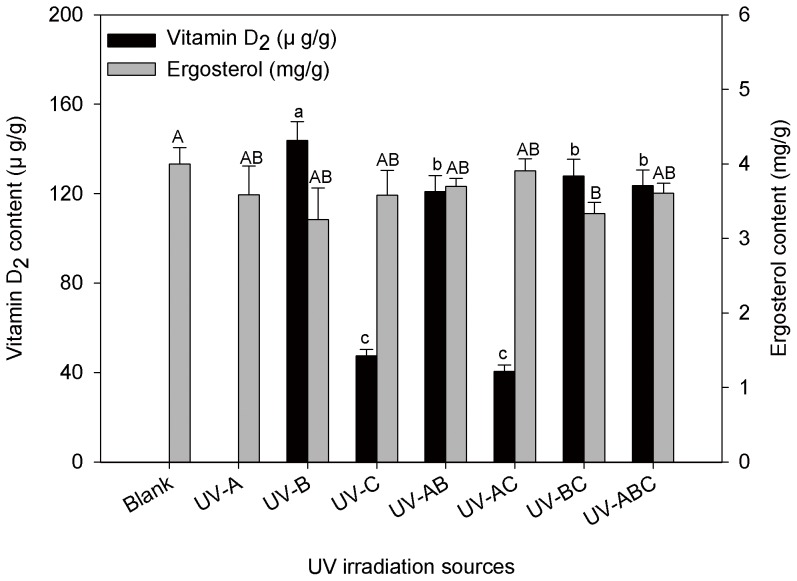
Effect of UV irradiation sources on the efficacy of vitamin D2 synthesis in oyster mushrooms.Results are expressed as the mean±SD of three replicates; Different small or capital letters are significantly different at p<0.01.